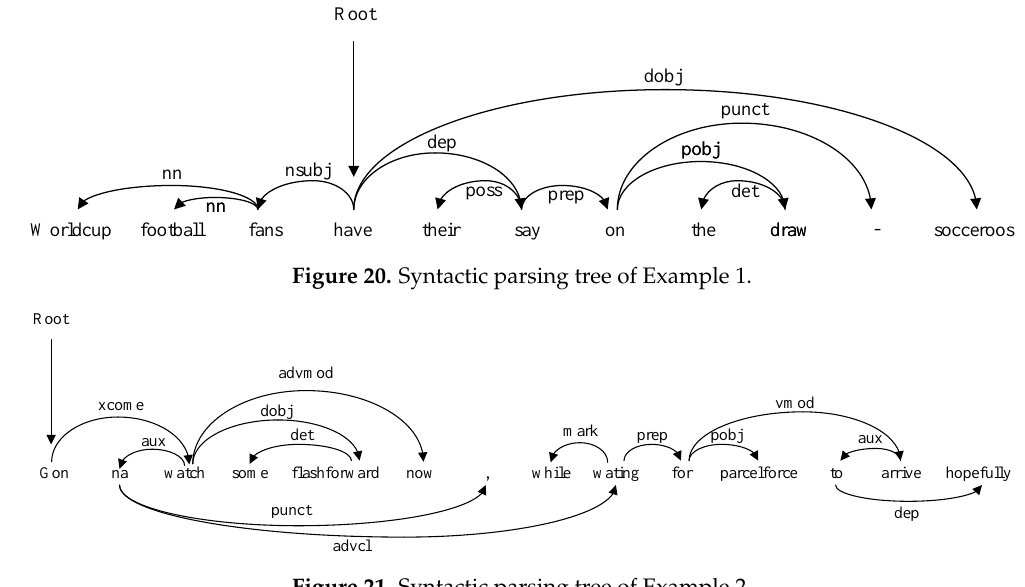
Figure 21. Syntactic parsing tree of Example